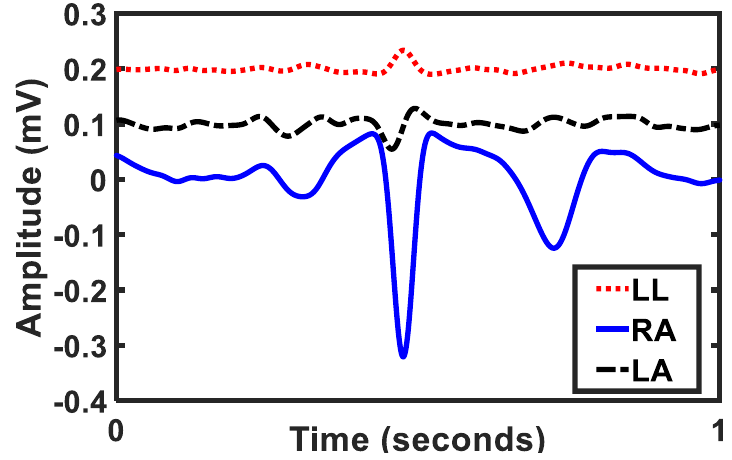
Figure 5. Comparison of the left arm (LA), right arm (RA), and left leg (LL) potentials. The RA has the peak to peak amplitude of 0.4 mV, while the LA has 0.07 mV, and the LL has 0.04 mV (patient ID 13).